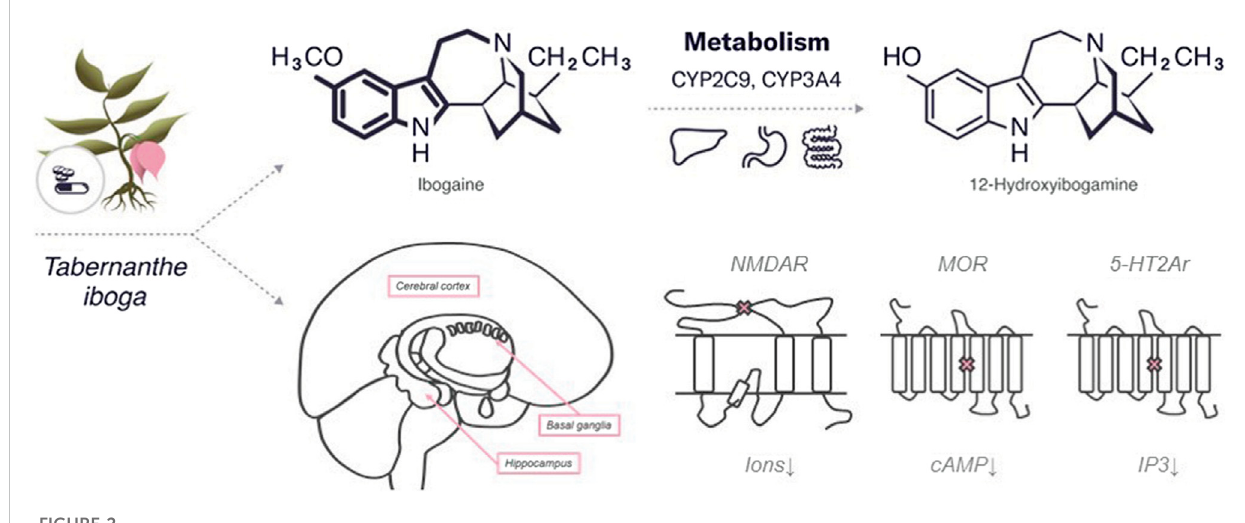
FIGURE 2 An overview of the characteristics of